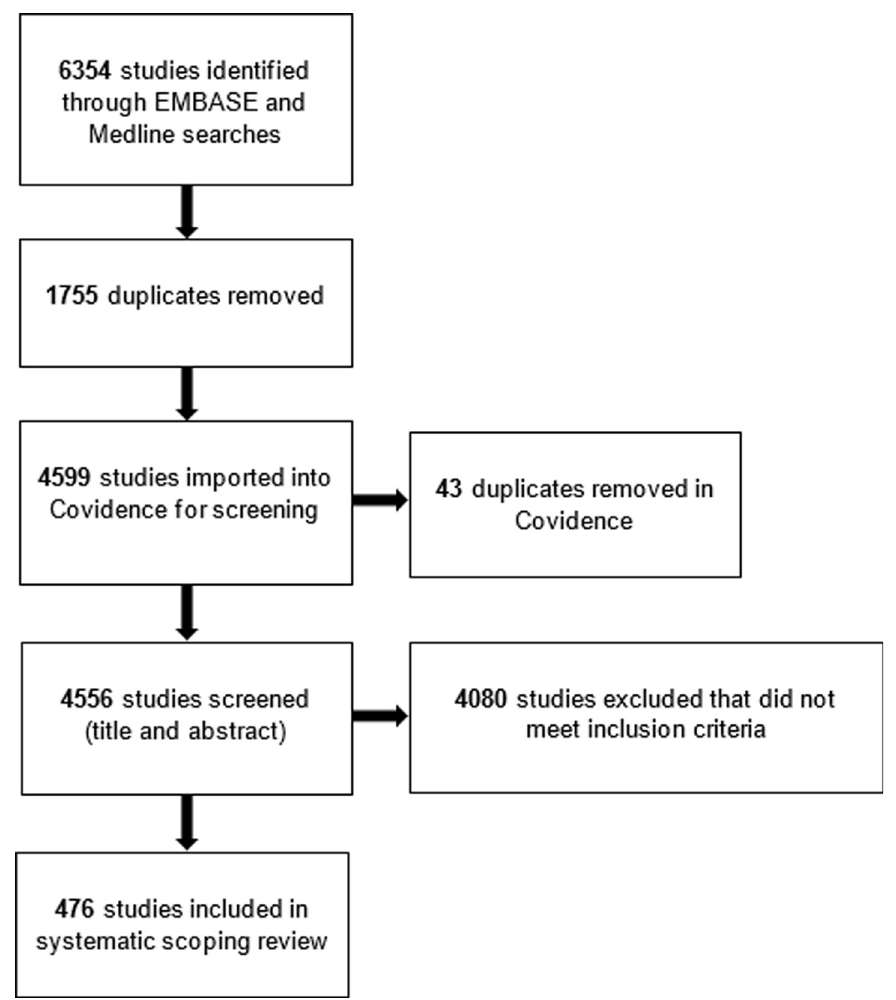
Fig 1. PRISMA diagram. Prisma diagram of citation selection